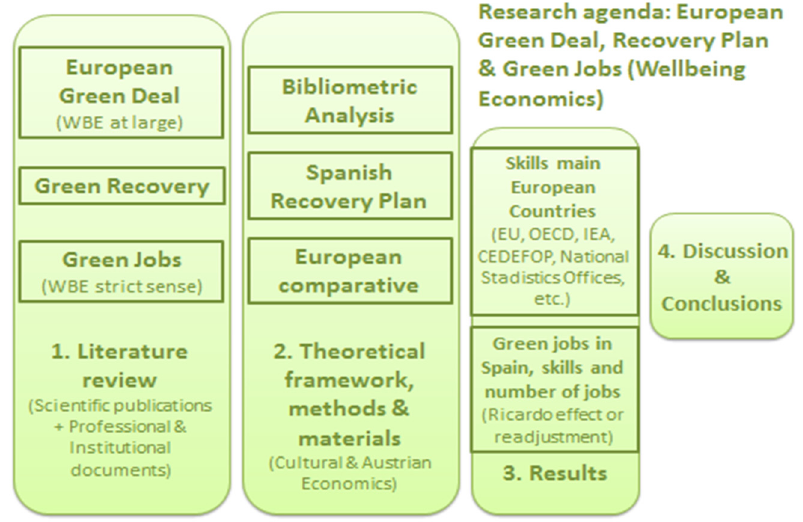
Figure 2. Structure and methodology (research plan). Source: own elaboration.